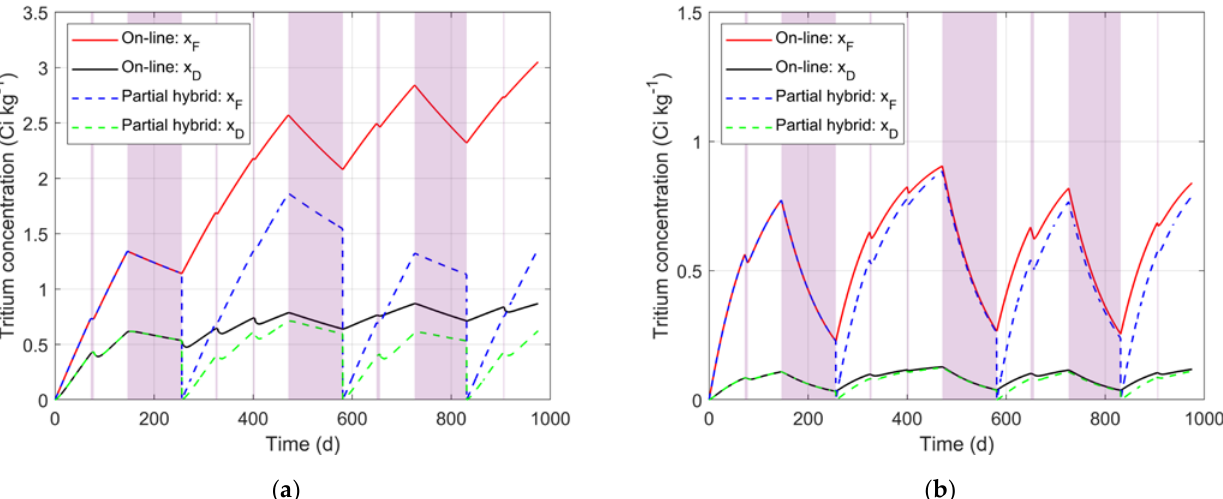
Figure 5. Increase of tritium concentration in primary coolant ( x F ) and in the distillate stream ( x D ) under assumed plasma operative sequence for the on-line (solid lines) and the partial hybrid strategy (dashed lines): ( a ) maximum target tritium concentration in PHTS of 5 Ci kg −1 ; ( b ) maximum target tritium concentration in PHTS of 1 Ci kg − 1 .